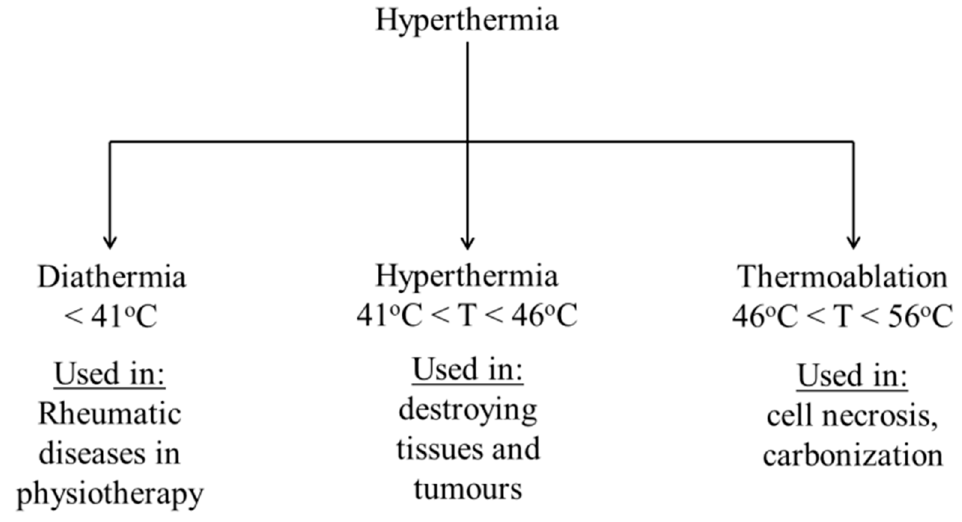
Figure 1. Classifications of hyperthermia and their uses.